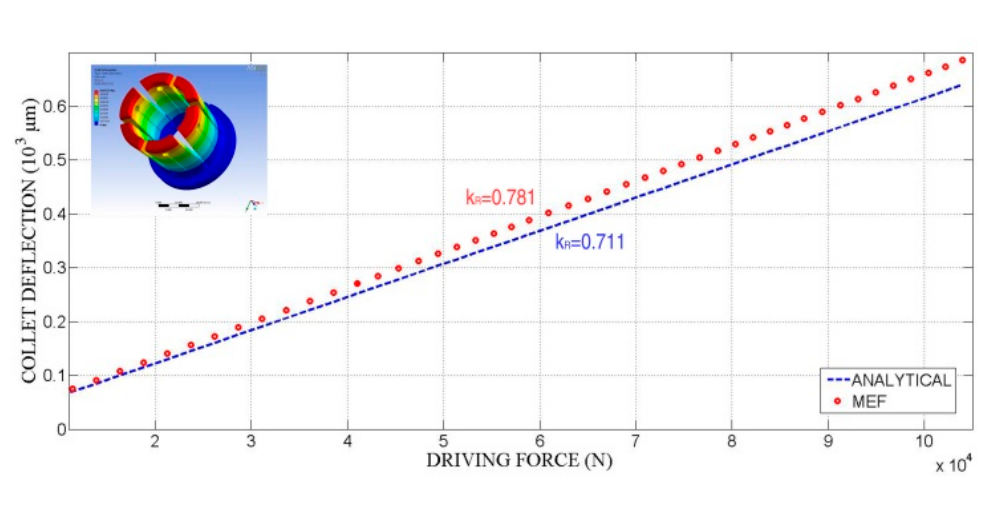
Figure 16. Proposed finite element model in CATIA.